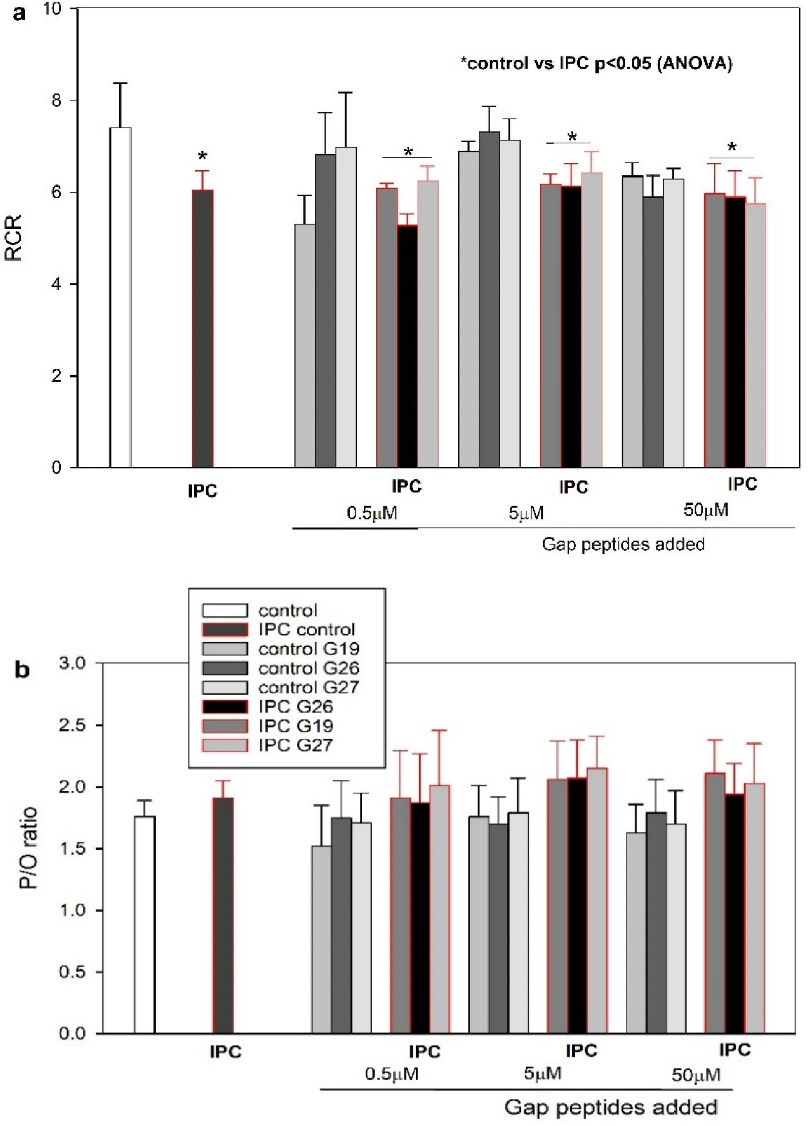
Figure 3. Subsarcolemmal mitochondrial respiratory control ration (RCR) and phosphate/oxygen (P/O) ratio. ( a ) Respiratory control ratio (RCR) as max O 2 flux (OXPHOS) at saturating [ADP] divided by state 2 leak respiration (glutamate—maleate as substrates). * p < 0.05 by ANOVA compared to mitochondria from hearts not subjected to IPC. ( b ) Phosphate/oxygen (P/O) ratio as µmol ADP added divided by µmol oxygen used (in the presence of glutamate—maleate). The grouped bars represent the presence of increasing concentrations of Gap peptides (0 and 0.5, 5, 50 µM as indicated) in the respiration chambers: Gap19 (G19), Gap26 (G26), Gap27 (G27).